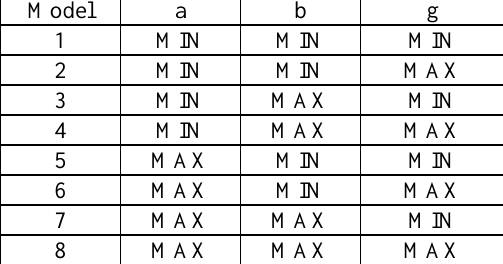
Combinations of minimum and maximum RBS flange cut dimensions. Model a b